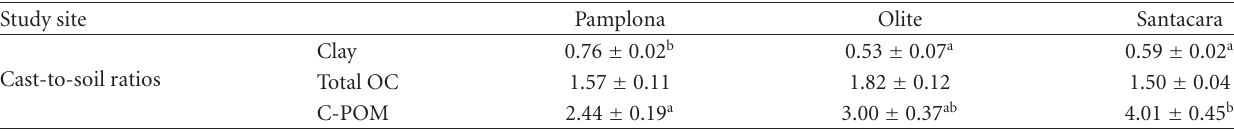
Table 3: Cast-to-soil ratios of clay, total organic C, and C in the form of POM (C-OPM) at the three study sites. Values followed by the same letter in the same row belong to the same Duncan’s homogeneous groups ( P < . 05) for each parameter among sites. Means ± standard error ( n =